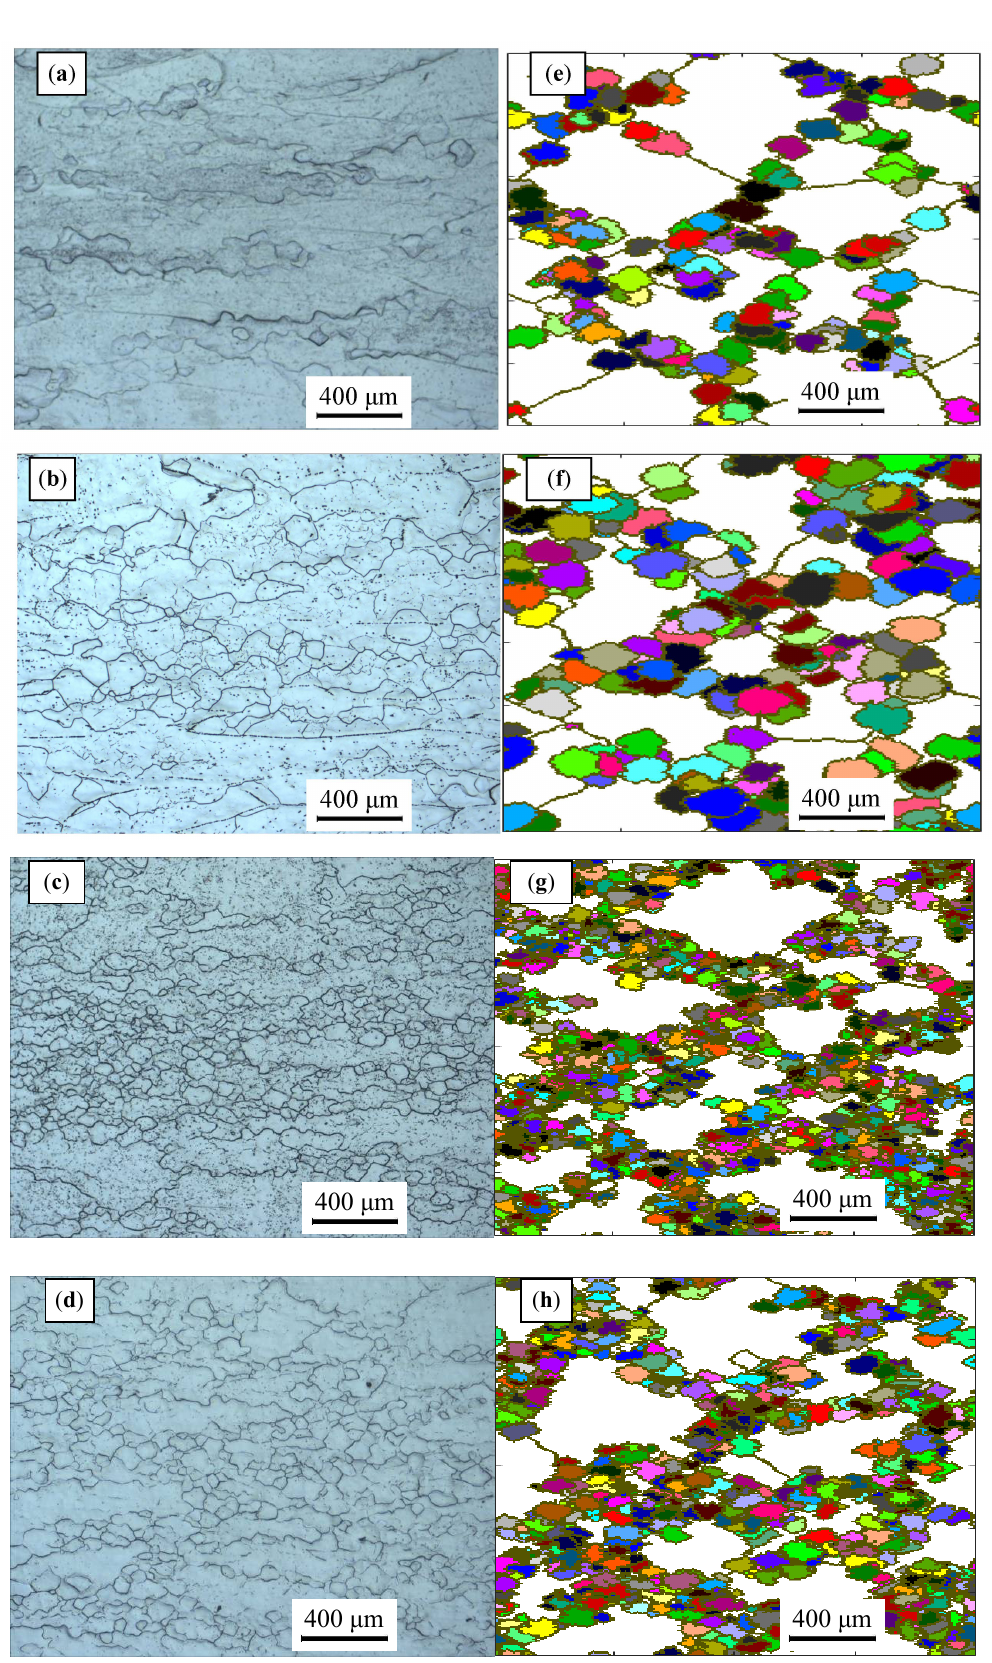
Figure 15. Microstructure of the 47Zr-45Ti-5Al-3V alloys after hot-working and CA simulation result: ( a,e ) 900 °C/10 −3 s −1 , ( b,f ) 950 °C/10 −3 s −1 , ( c,g ) 1000 °C/10 −2 s −1 and ( d,h ) 1050 °C/10 −2 s −1 .